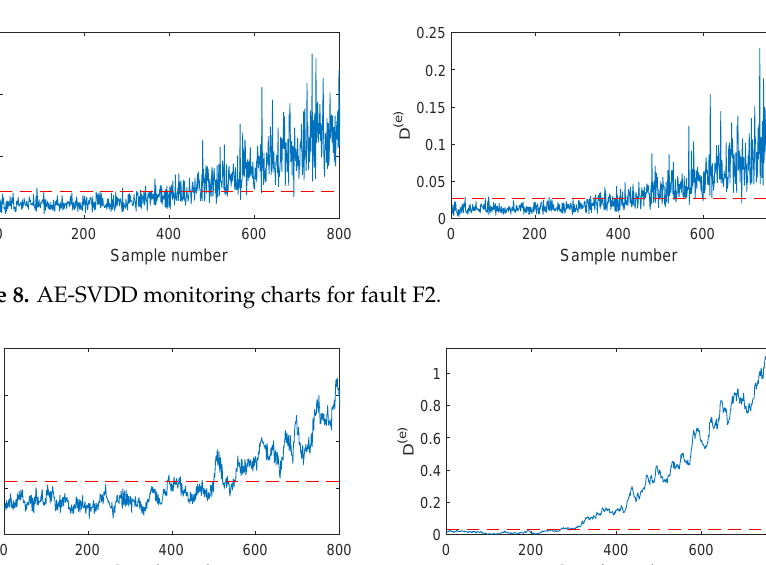
Figure 7. PCA-SVDD monitoring charts for fault F2.